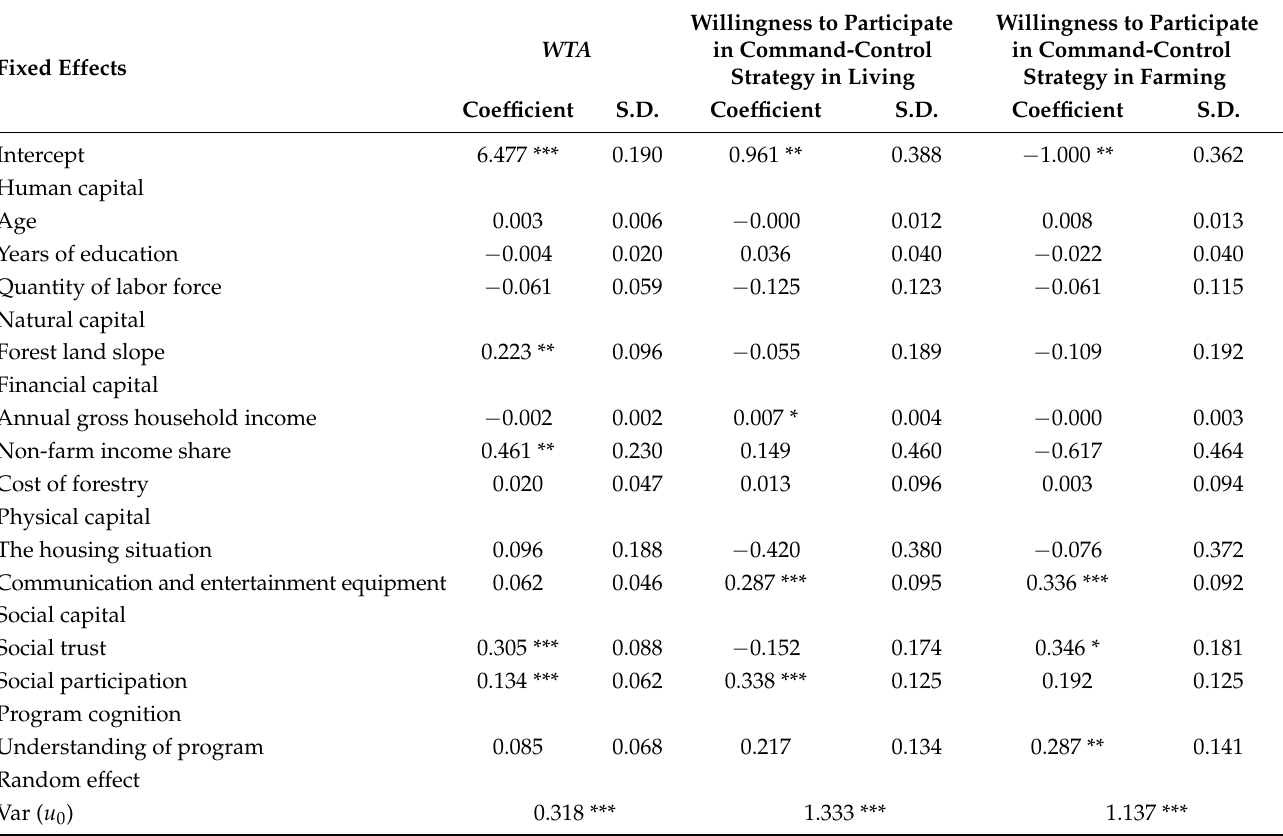
Table 4. Results of random effect